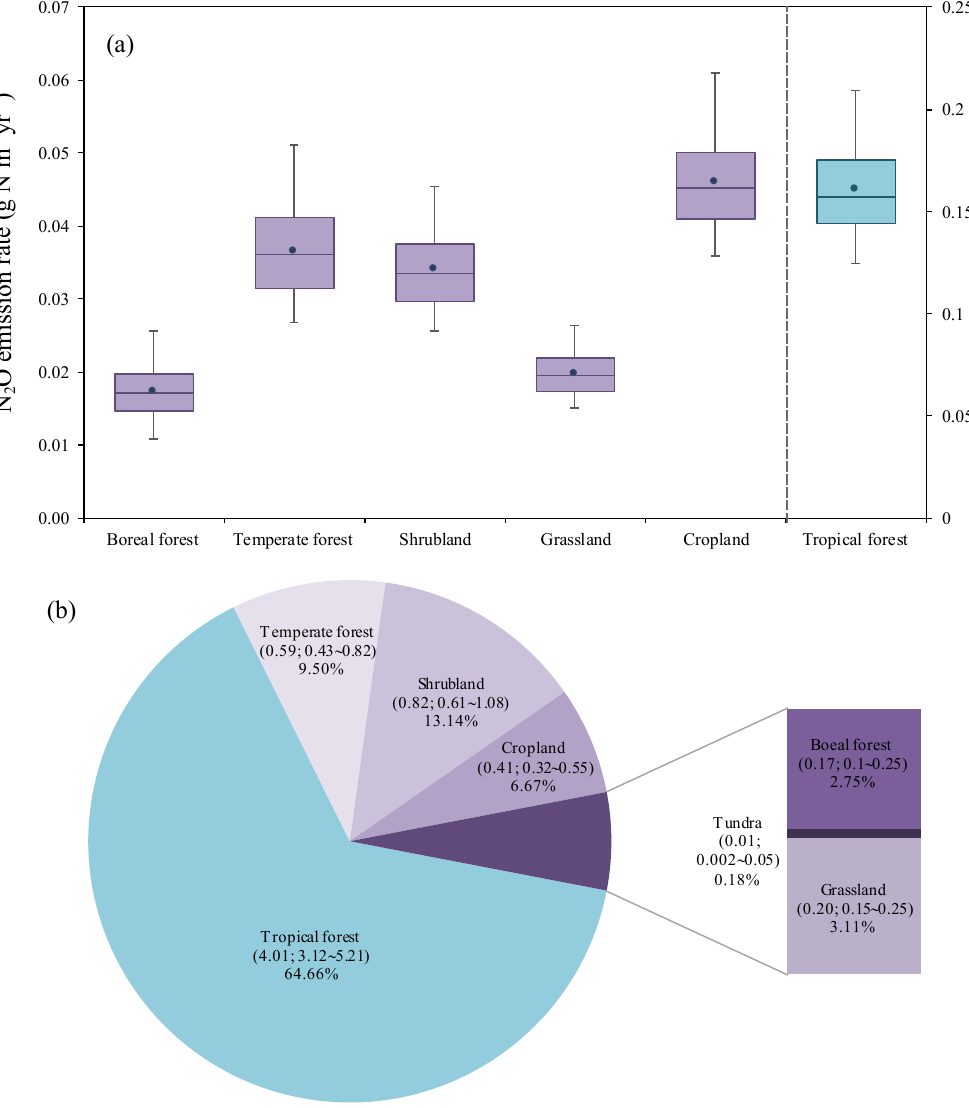
Figure 6. (a) Estimated N 2 O emission rate at the biome level in 1860 with the median value (solid line), the mean (solid dot), and the uncertainty range of emission rates from different biomes. The emission rate in the tundra was removed because of the extremely small value (less than 0.003gNm − 2 yr − 1 ). (b) Estimated N 2 O emission (TgNyr − 1 ) with uncertainty ranges and its percentage (%) at the biome level in